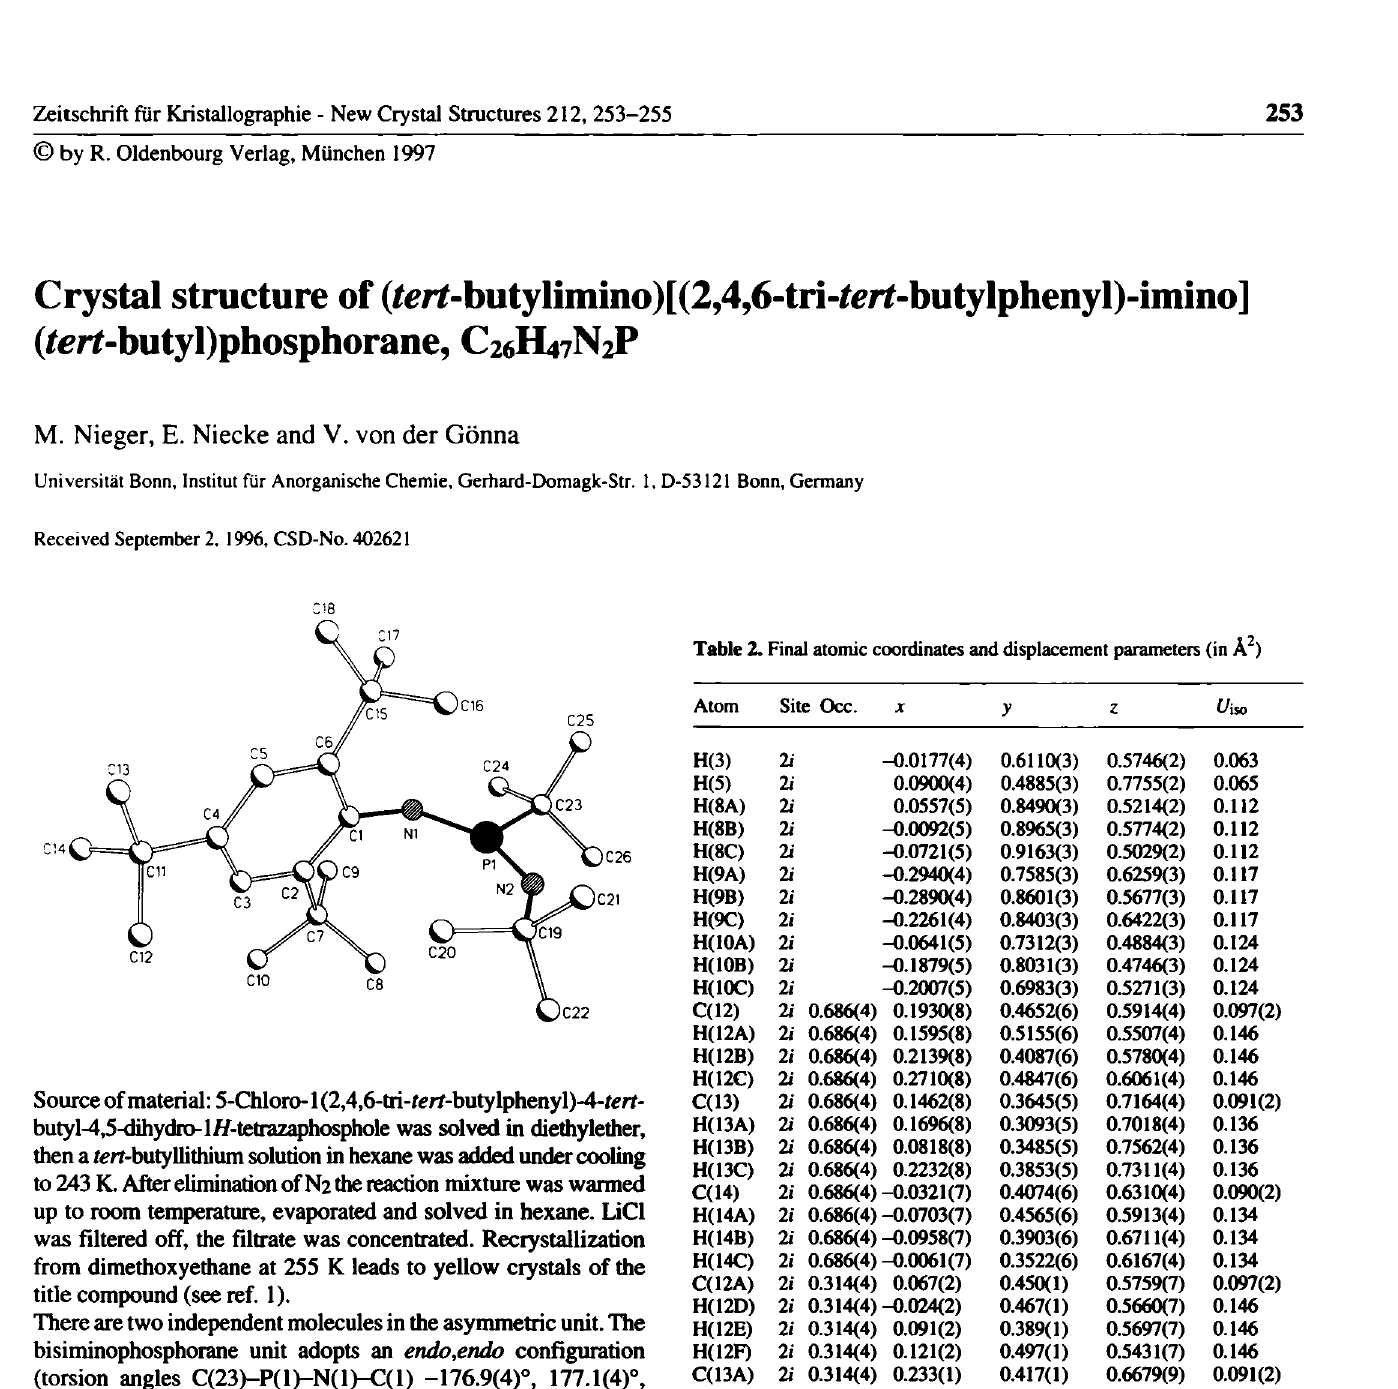
Table 1. Parameters used for the X-ray data collection